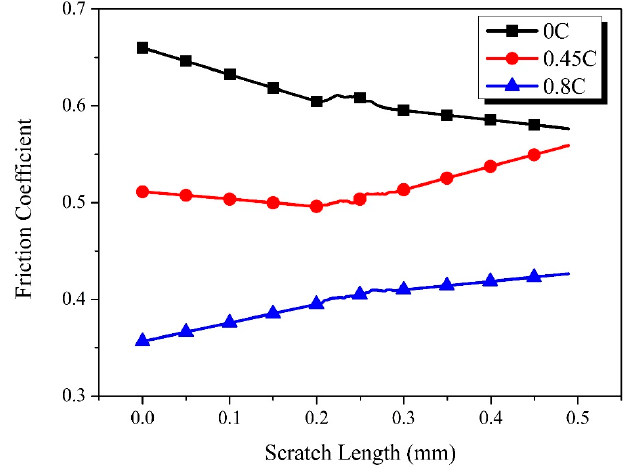
Figure 10. Variation of friction coefficient with scratch length.